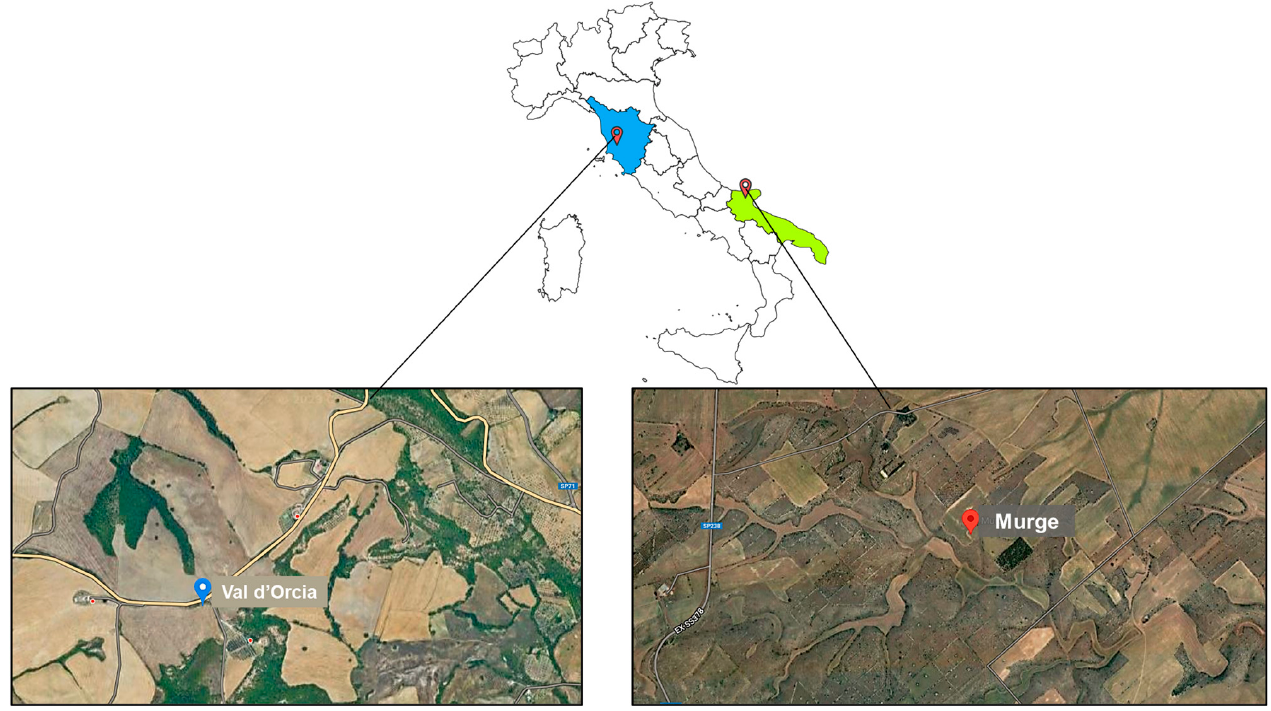
Figure 1. Geographical location and areas of origin for the wheat husk samples analyzed. Both raw matrices and hydroalcoholic wheat husk extracts were characterized by HPLC chemical, spectrophotometric, anti-inflammatory, and cytotoxicity analysis, as shown in Figure